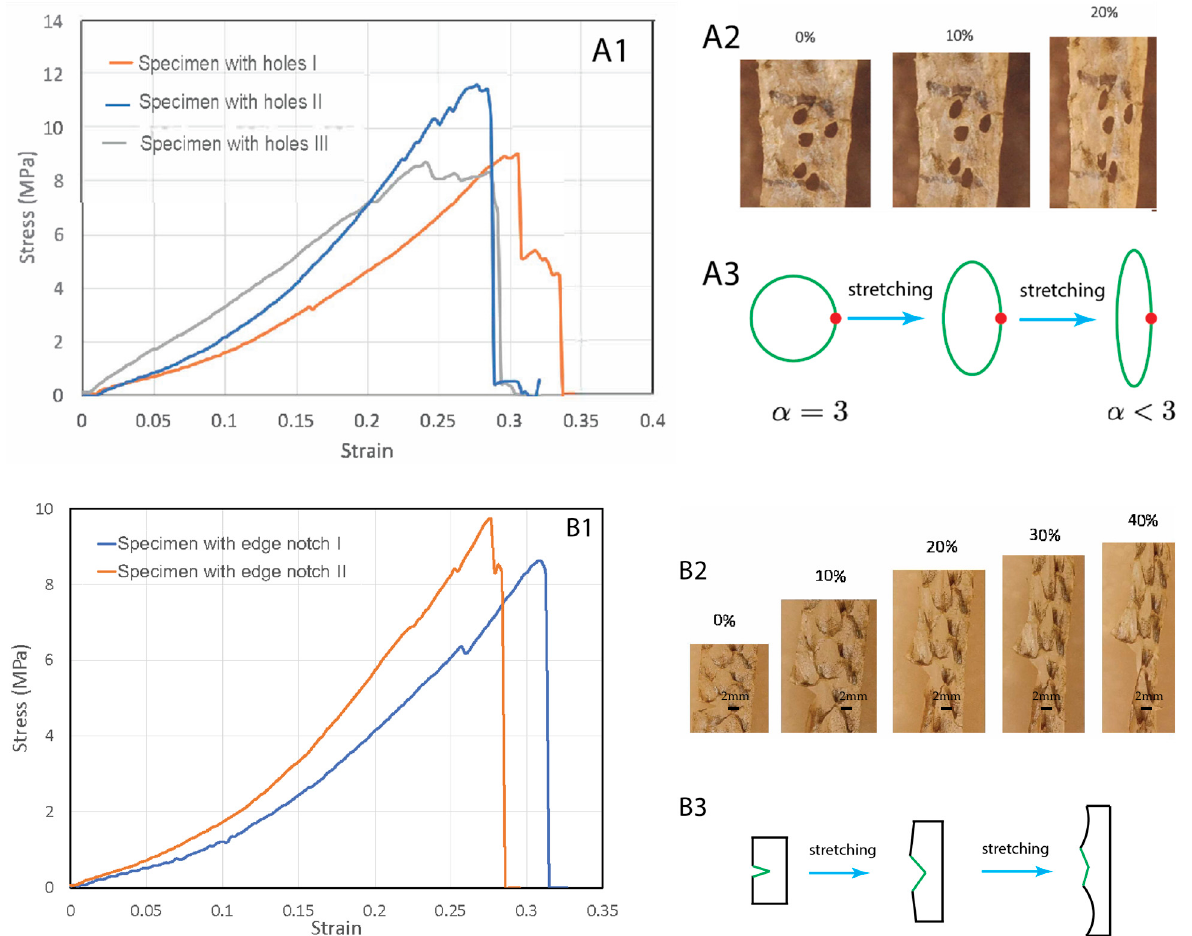
Figure 3. Tear tests of fish skin strips with holes ( A1 – A3 ) and an edge notch ( B1 – B3 ). ( A1 ) Stress–strain curves of three specimens with pre-introduced holes. ( A2 ) The holes become elongated along the stretching direction, with a reduced stress concentration factor. ( A3 ) Schematics of the hole shape change due to stretching, resulting in reduced stress concentration factor. ( B1 ) Stress–strain curves of three specimens with a pre-introduced edge notch. ( B2 ) Under increasing stretch, the edge notch did not expand, but blunted. ( B3 ) A schematic illustration of the edge notch blunting due to stretching.